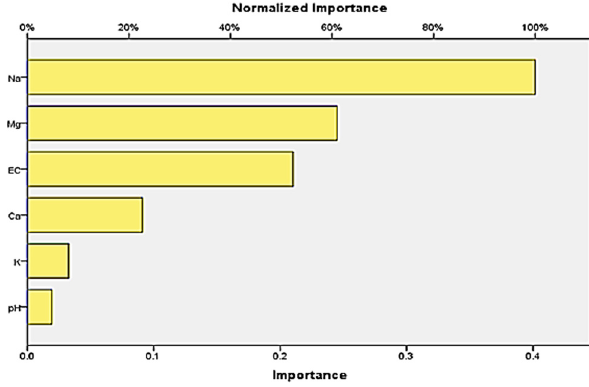
Figure 7: Input parameter